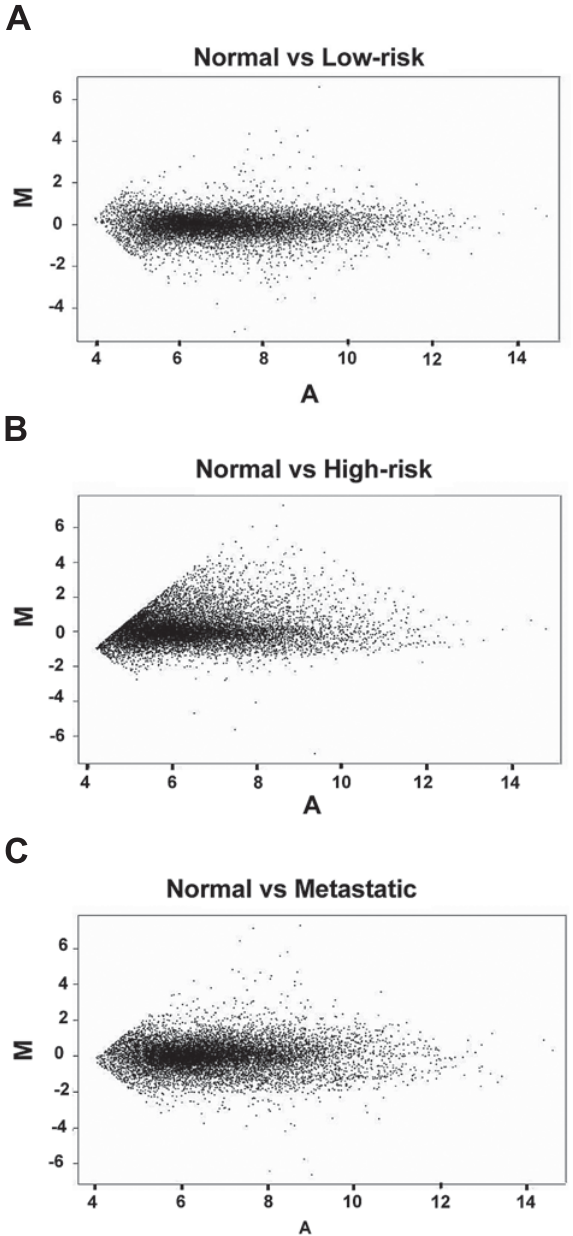
Figure 1 – Representation of gene expression variation in dif- ferent ranges of intensity (MA-plot) between (A) normal vs. low- risk, (B) normal vs. high-risk, and (C) normal vs. metastatic